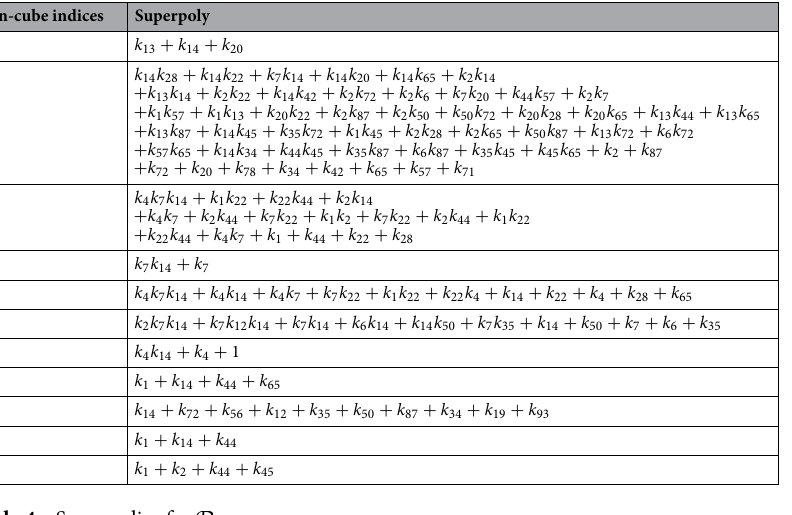
Table 4. Superpolies for P 376